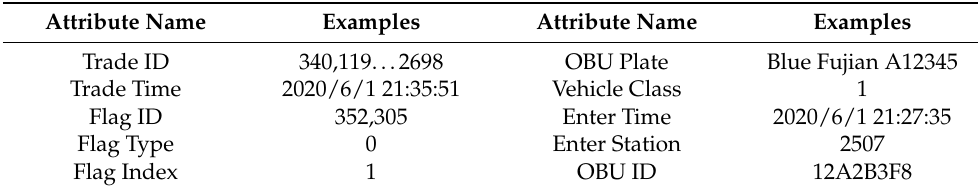
Table 1. Partial transaction data attribute table of ETC gantry